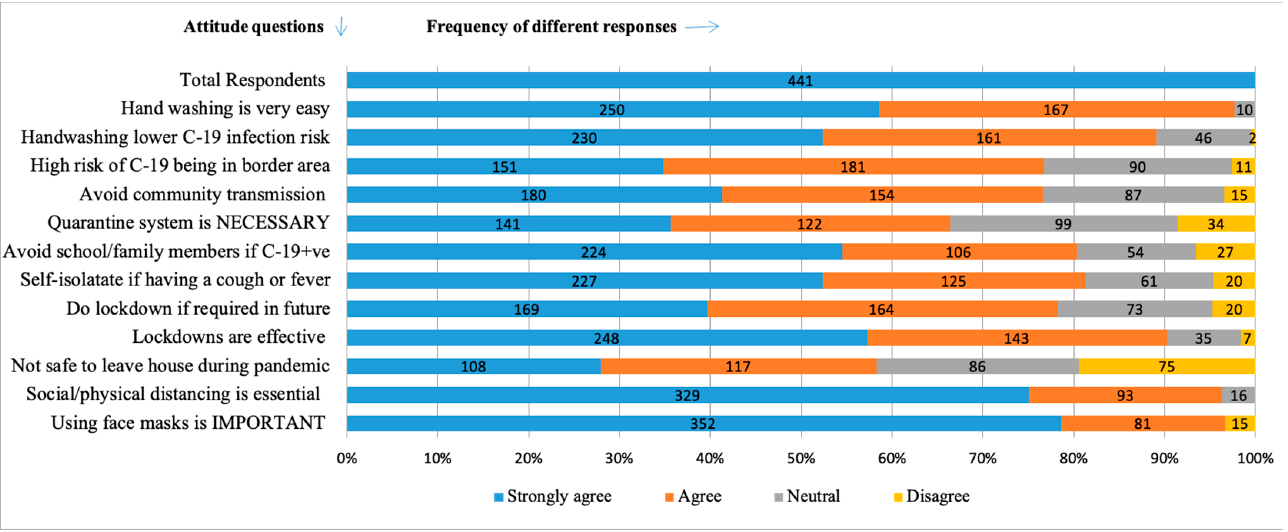
Figure 3. Frequency distribution of responses to attitude questionnaire among study participants in Phuentsholing Hospital, Bhutan (C-19 = COVID-19; +Ve = Positive).